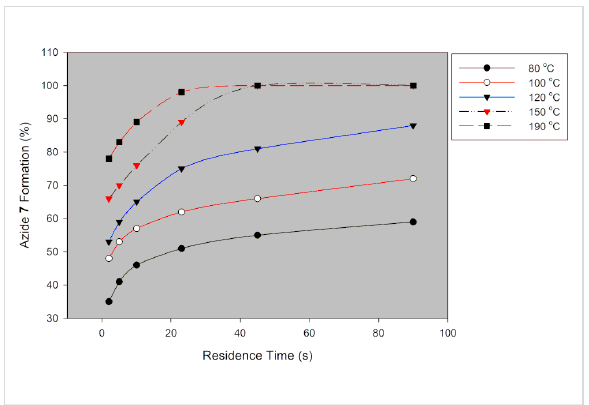
when less NaN 3 (2 equiv) was used. The reaction was further optimised using acetonitrile as acetamide 6 (0.1 M) solvent and